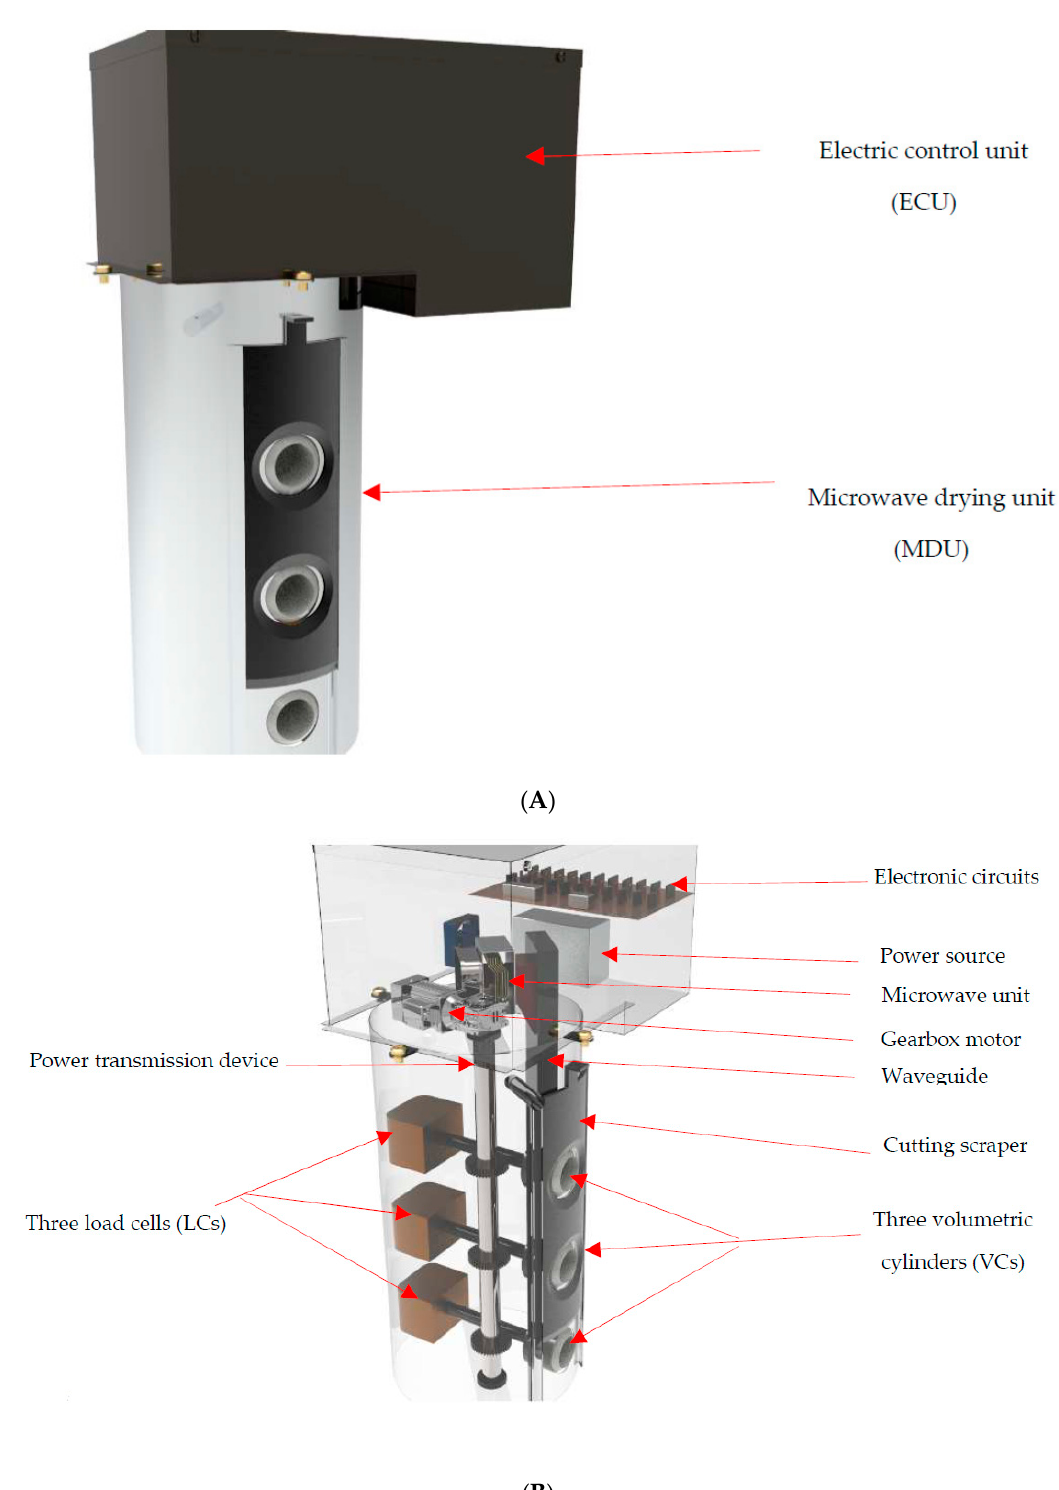
Figure 2. ( A ) Two main subunits of the digital electromechanical system (DES); ( B ) Description of the DES. the